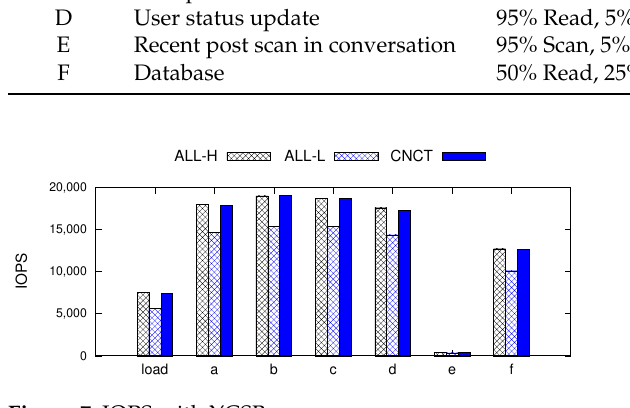
Figure 7. IOPS with YCSB.